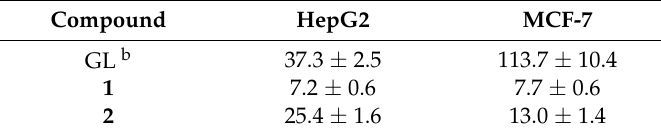
Table 3. In vitro cytotoxicity of products 1 and 2 (IC 50 , µ M).